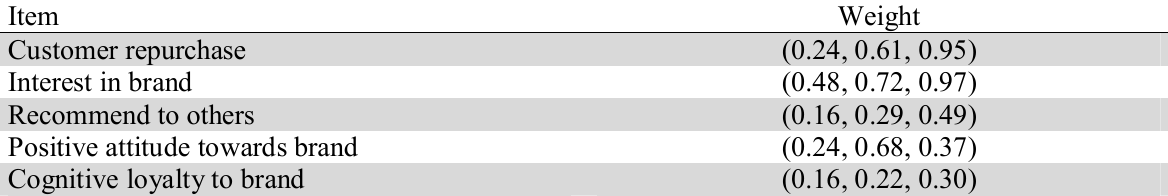
The summary of ranking five main criteria using